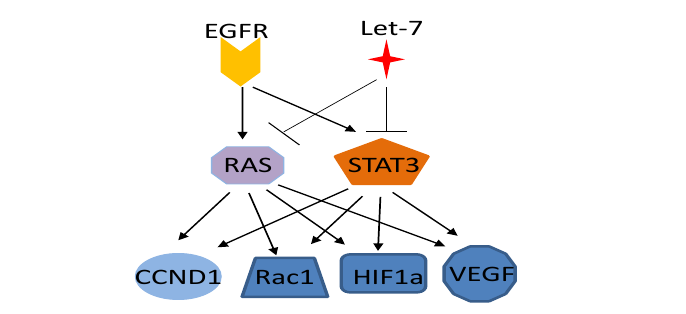
Figure 3. Ras and STAT3 mediated parallel pathways for EGFR and let-7. Ras and STAT3 has common upstream regulators and downstream